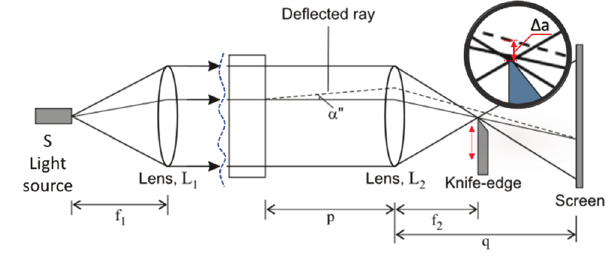
Fig. 7. Diagram of shadow visualization [21] (description in the text) The light source is placed at the focus of the lens and produces a wide parallel beam passing through the sample. The light is focused by the lens (L2), and then reaches the screen of the measuring camera, set so as to obtain a sharp image of the measured sample. In the focus of the lens (L2) the knife-edge was set, also known as an optical knife, that is moved in a plane perpendicular to the optical axis of the system. The path of any ray of light that has not been af- fected by changes in sample density is marked with a solid line, and the angle at which the light refracted α (when such density changes occur) – was marked with a dashed line.